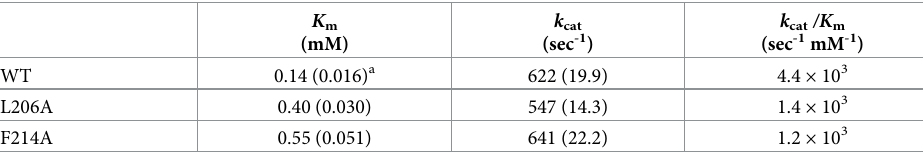
Table 2. Kinetic parameters of EstDL136 and its